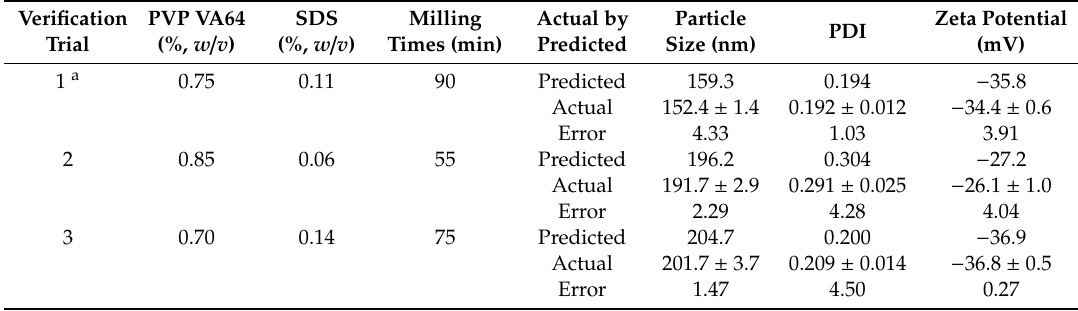
Table 4. Verification of central composite design for optimization of CXL-NC formulation.